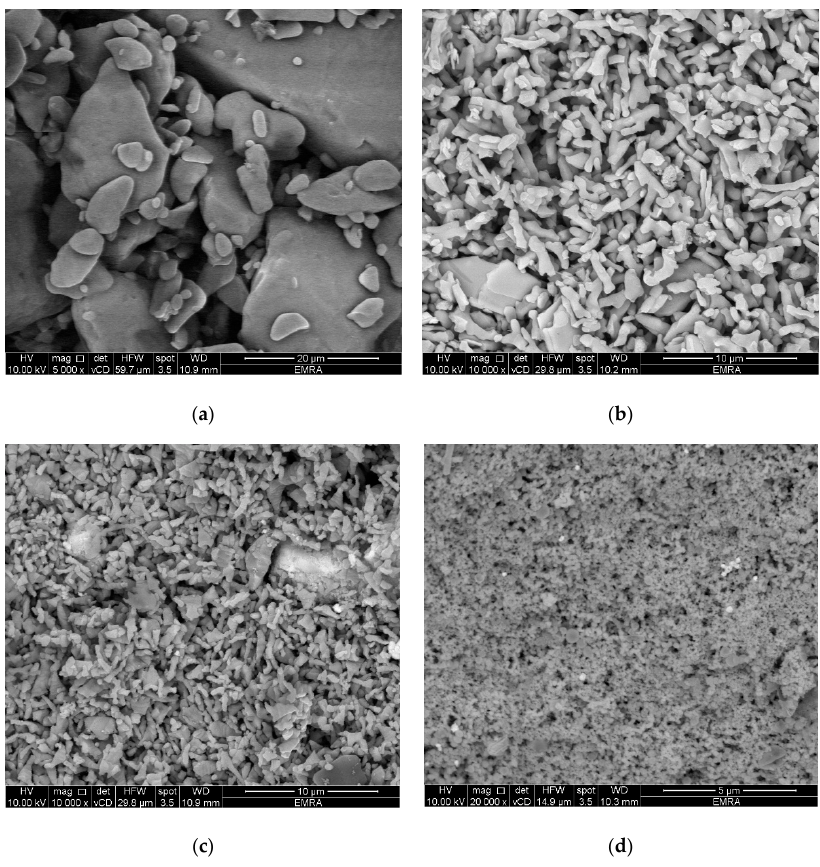
Figure 2. SEM of papaverine HCl ( a ) in complex with V(III) ( b ), Ru(III) ( c ) and Au(III) ( d ).